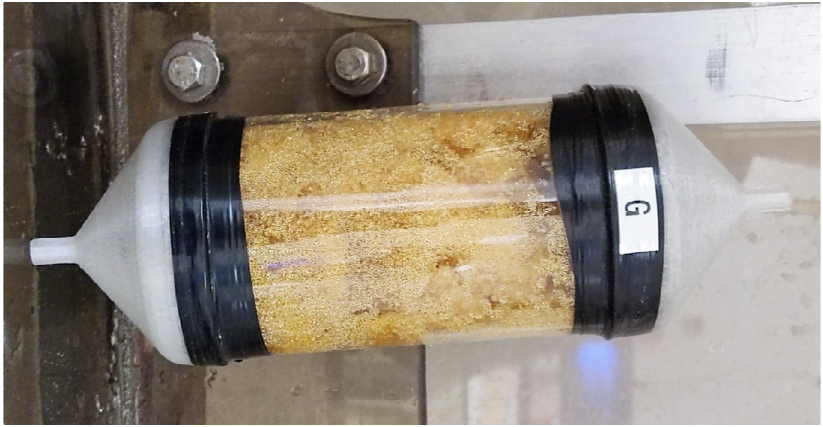
Figure 3. Test Sample G—representative picture.